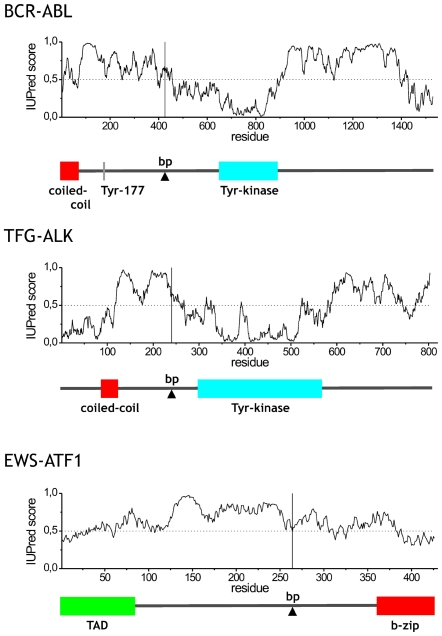
Predicted disorder and domain structure of select fusion proteins.Disorder predicted by the IUPred algorithm and domain structure identified by Pfam are shown for BCR-ABL, TFG-ALK, and EWS-ATF1, values above 0.5 are considered disordered. The position of the breakpoint is marked by a vertical line in the disorder plot whereas the elements critical for the oncogenic function are shown as colored rectangles (arrowhead for breakpoint) on the domain models below. The critical elements are connected by long segments of structural disorder.